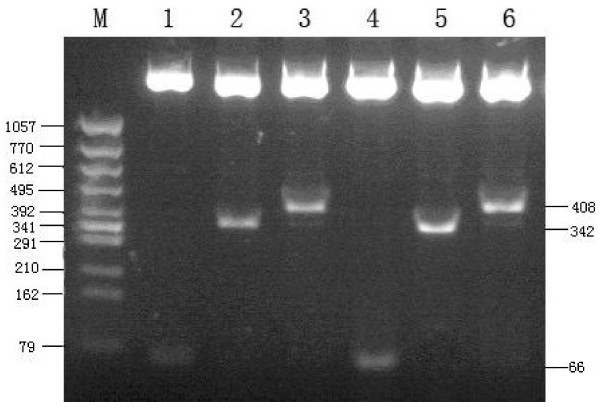
Restrictive enzyme incision analysis for pGensil-1/MTA1 shRNA plasmid using RT-PCR. M: DNA Marker. lane 1: pGenesil-1/MTA1 shRNA(pGM1) plasmid was cut off by BamHI and HindIII. lane 2: pGenesil-1/MTA1 shRNA(pGM1) plasmid was cut off by BamHI and XbaI.lane 3: pGenesil-1/MTA1 shRNA(pGM1) plasmid was cut off by HindIII and XbaI. lane 4: pGenesil-1/MTA1 shRNA(pGM2) plasmid was cut off by BamHI and HindIII. lane 5: pGenesil-1/MTA1 shRNA(pGM2) plasmid was cut off by BamHI and XbaI. lane 6: pGenesil-1/MTA1 shRNA(pGM2) plasmid was cut off by HindIII and XbaI.